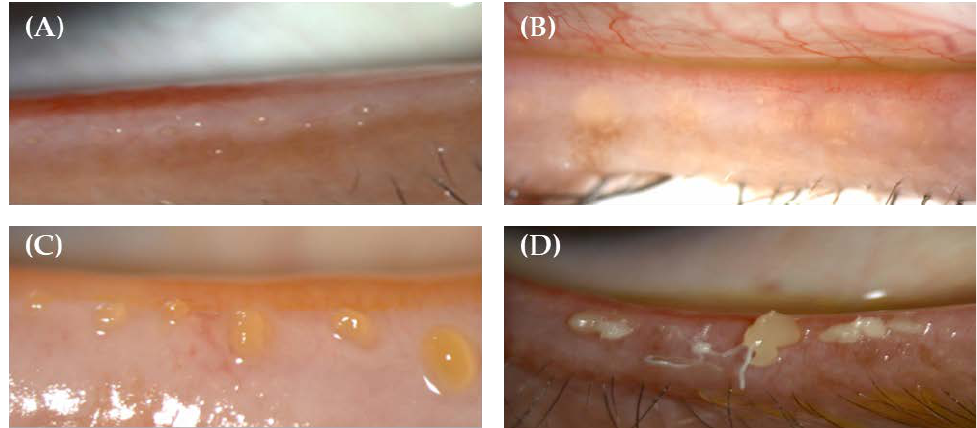
Figure 1. Representative images of meibum quality grading. ( A ) Grade 0, clear fluid; ( B ) Grade 1, cloudy fluid; ( C ) Grade 2, cloudy particulate fluid; ( D ) Grade 3, inspissated, toothpaste-like.